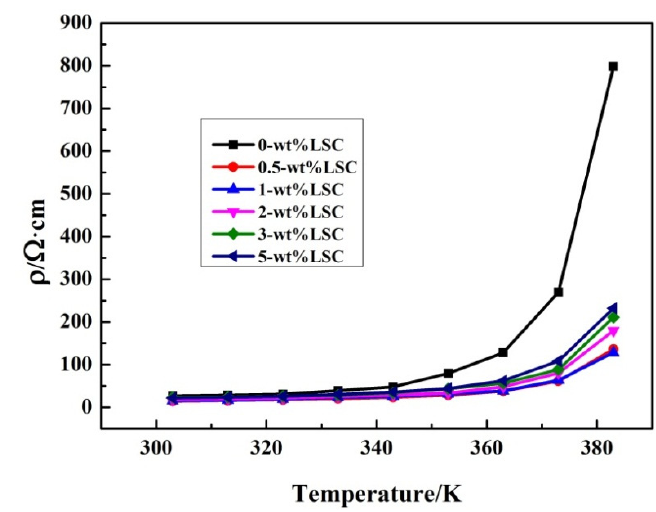
Figure 8. Resistivity of the semiconductive composites with different mass fractions of LSC as a function of temperature.